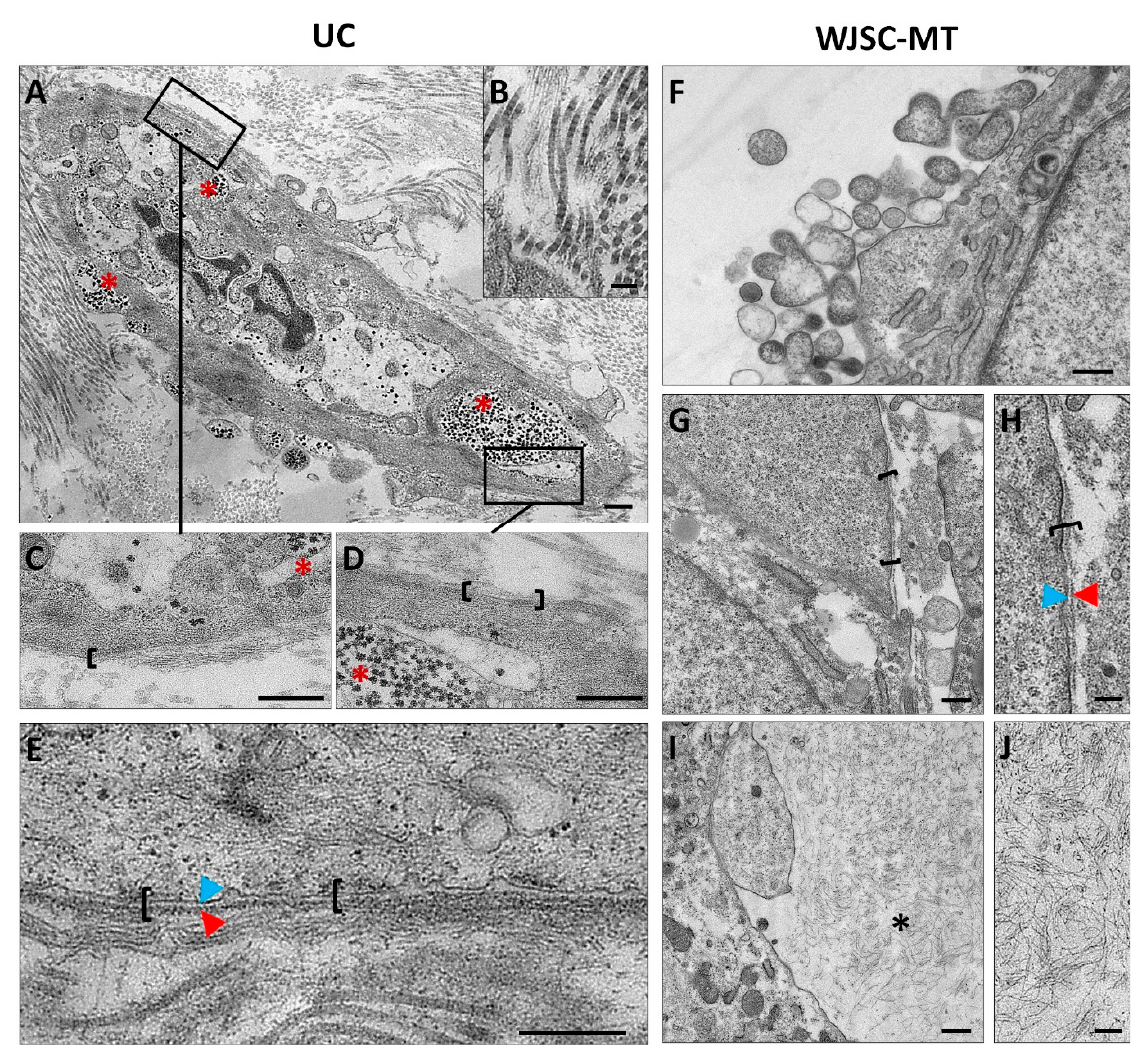
Figure 7. Ultrastructural analyses by transmission electron microscopy (TEM) of Wharton’s Jelly- derived stem cells (WJSC) in full-term umbilical cord (UC) and WJSC-derived microtissues (WJSC- MT). Large amounts of intracellular glycogen (red asterisks) are seen in a lower magnification cell image ( A ) and magnified areas ( C , D ). A representative image of collagen fibers and non-fibrillar components of ECM full-term UC is represented in ( B ). A discontinuous basal lamina-like (BL) pericellular structure (black brackets), formed by lamina lucida (blue arrowhead) and lamina densa (red arrowhead), is also visible in full-term UC ( C – E ) and 4 days of ex vivo development (EVD) WJSC-MT ( G , H ). Large amount of extracellular vesicles in WJSC-MT at 4EVD ( F ) and non-fibrillary content in extracellular matrix core (black asterisk) was observed in WJSC-MT at 7EVD ( I , J ). Scale bar: 500 nm ( A , C – G , I ) and 200 nm ( B , H , J ).